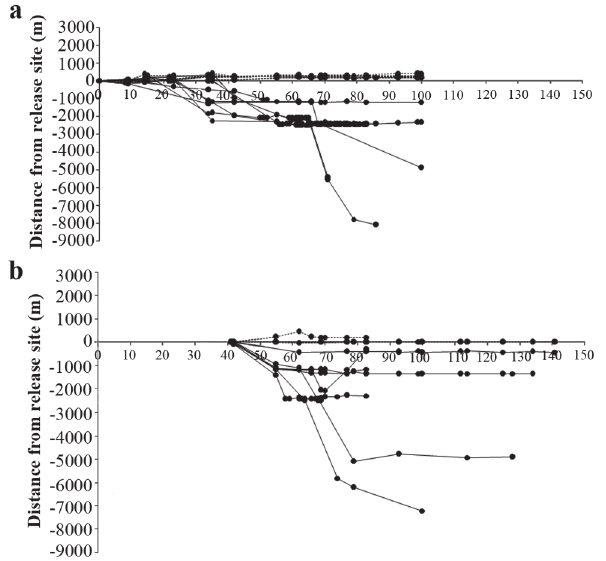
Fig. 2 . Distances covered by batch 1 ( a ) and batch 2 ( b ) dourados. Release point = Stream position 0. Positive values = upstream movement (hatched lines); negative values = downstream movement (solid lines).